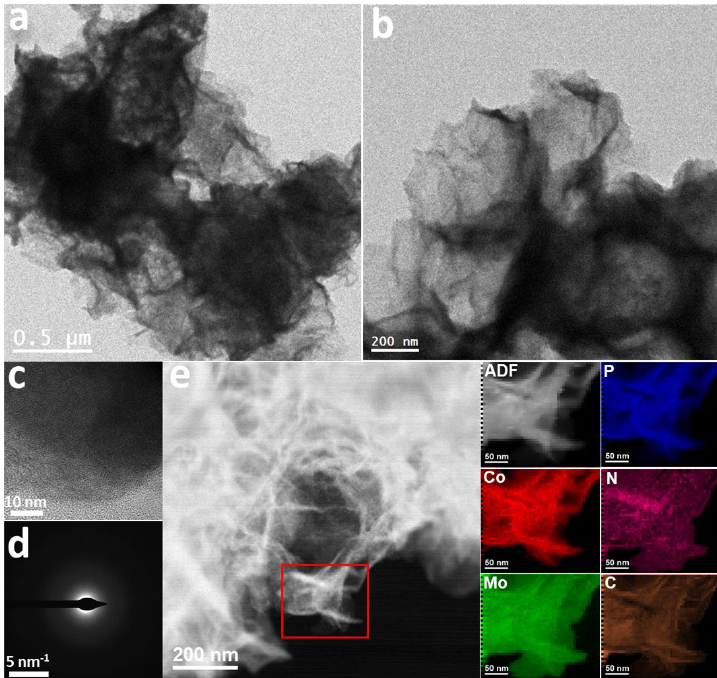
Figure 2. ( a , b ) TEM images, ( c ) HRTEM image, ( d ) SAED pattern and ( e ) HAADF STEM image and EELS chemical composition maps obtained from the red squared area of the STEM micrograph. Individual Co L 2,3 edges at 779 eV (red), Mo M 4,5 edges at 230 eV (green), P L 2,3 edges at 132 eV (blue), N K edge at 401 eV (pink) and C K edge at 284 eV (orange). As expected, the XPS survey spectrum displayed the presence of C, N, O, P, Co and Mo elements on the surface of CoMoP (Figure 3c). The high-resolution P 2p XPS spectrum displayed two doublets, which we associated with P within the metal phosphide lattice (P 2p 3/2 = 129.7 eV), and a phosphate chemical environment (P 2p 3/2 = 133.8 eV) (Figure 3d) [41,47]. The Co 2p XPS spectrum displayed six peaks (Figure 3e). The main Co 2p contri- bution was assigned to Co within the phosphide lattice (Co 2p 3/2 = 779.3 eV). A second doublet was associated with Co within an oxide, hydroxide or phosphate chemical envi- ronment (Co 2p 3/2 = 781.5 eV). The last two bands were assigned to satellite peaks [28 – 30,48,49]. Finally, the Mo 3d XPS spectrum displayed two doublets assigned to Mo within the metal phosphide lattice (Mo 3d 5/2 = 228.2 eV) and an oxidized chemical environment (Mo 3d 5/2 = 233.0 eV) (Figure 3f) [50 – 52].